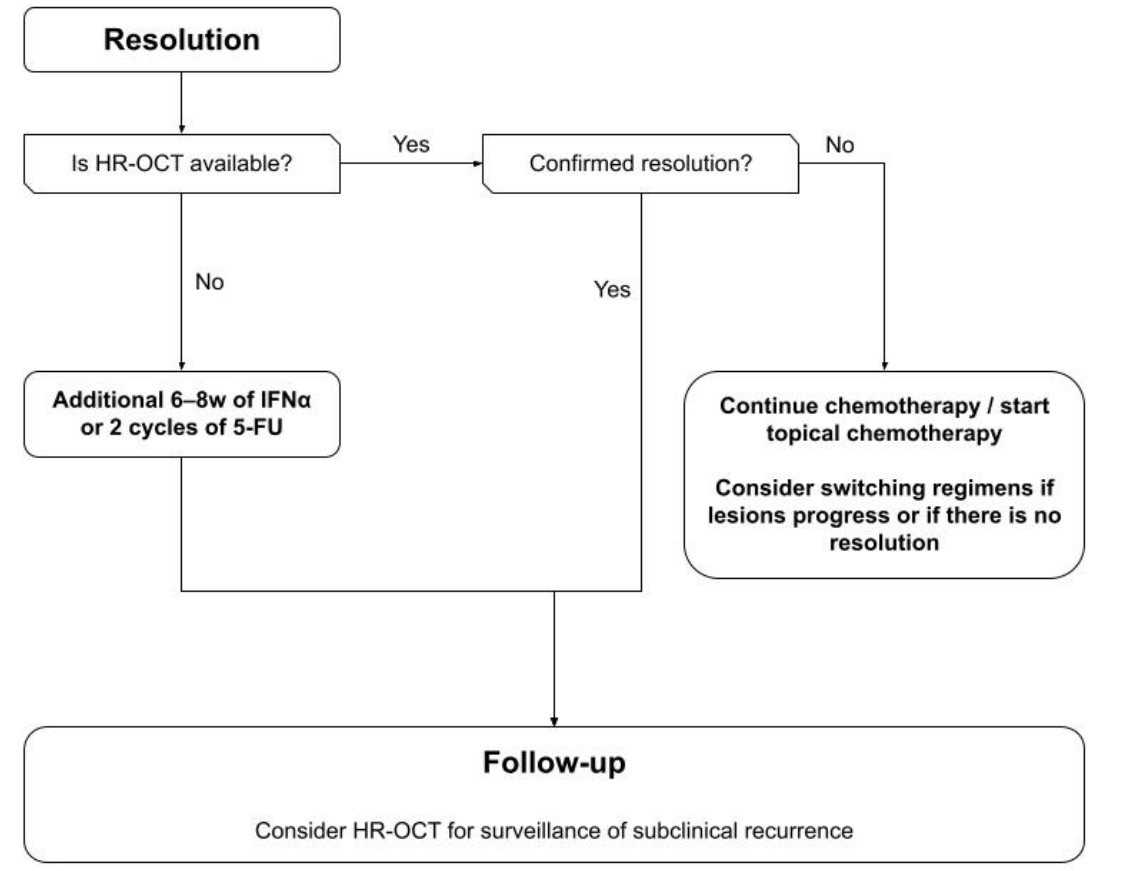
Figure 4. Flowchart guiding the monitoring of OSSN resolution and surveillance of disease recur- rence.